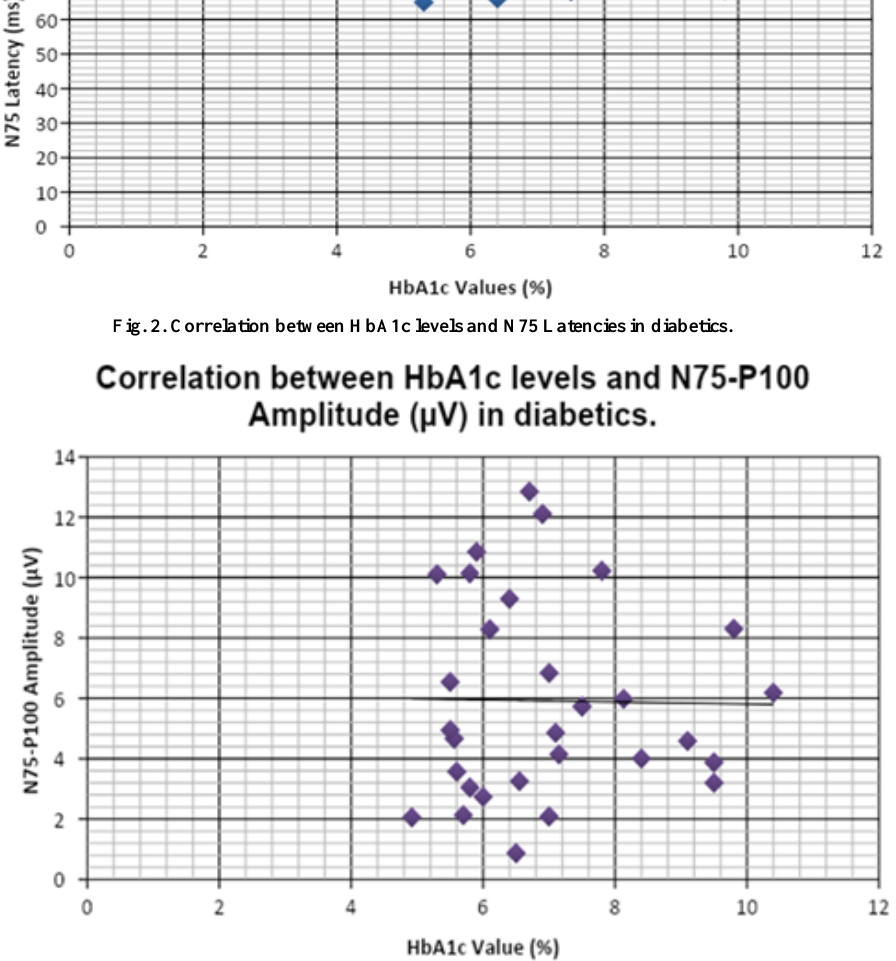
Fig. 3. Correlation between HbA1c levels and N75-P100 Amplitude (μV) in diabetics.